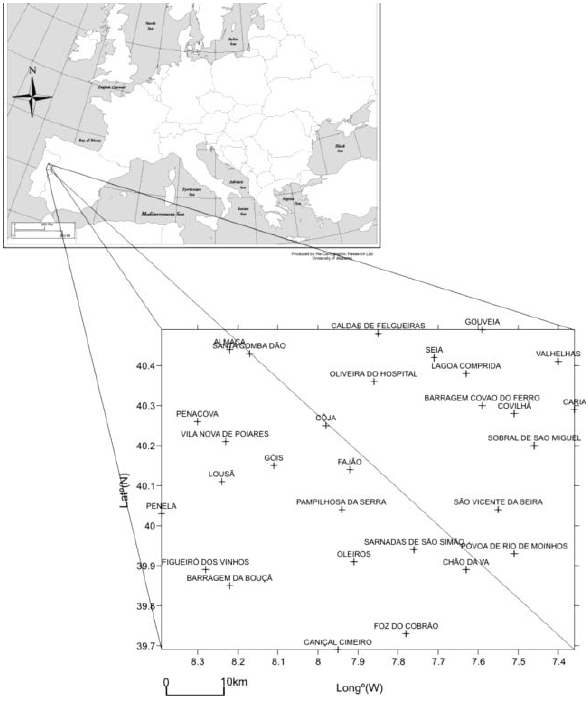
Fig. 1. Study area and stations in analysis (max), 1 st Quartil (Q1), Median (M), 3 rd Quartil